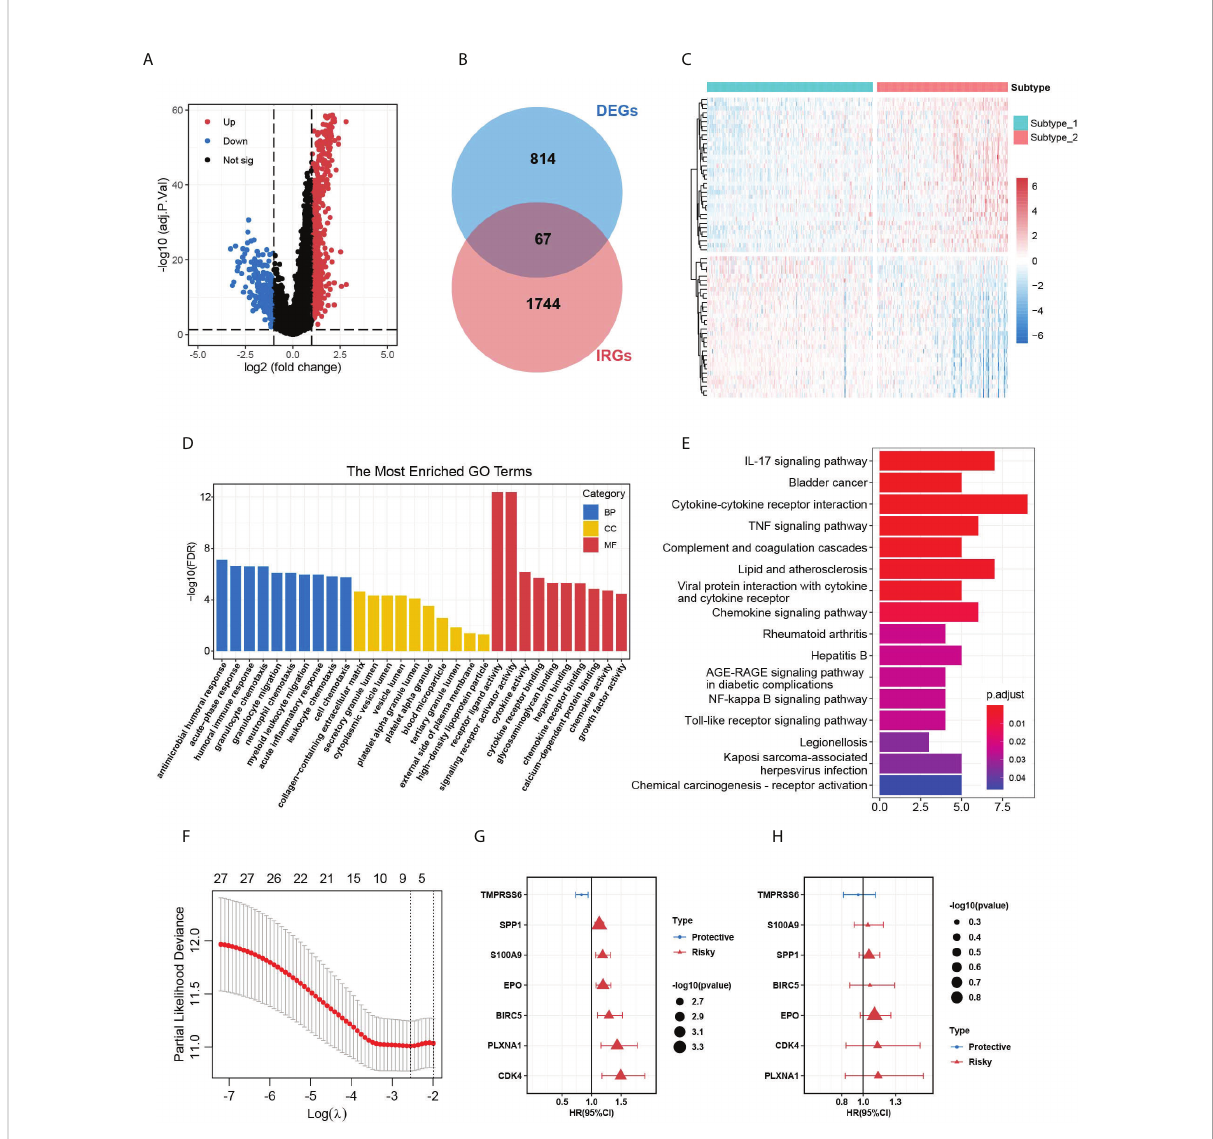
FIGURE 3 DEG analysis in the two HCC subtypes and the construction of HGSIS. (A) Volcano plot of 881 DEGs between the two HCC subtypes. (B) Venn plot showing 67 immune-related DEGs. (C) Heatmap of the IRDEGs in the two subtypes. (D, E) GO and KEGG enrichment analysis for the 67 IRDEGs. (F) Selection of the tuning parameter (lambda) in the LASSO model by 10-fold cross-validation. (G, H) Hazard ratio with 95% CI of the seven genes in the HGSIS signature computed by UniCox and MultiCox, respectively. HCC, hepatocellular carcinoma. GO, gene oncology; KEGG, Kyoto Encyclopedia of Genes and Genomes. HGSIS, hallmark-guided subtypes-based immunologic signature. IRDEGs, immune-related